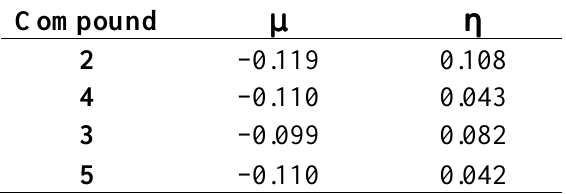
Table 3. Chemical potential ( m ) and Hardness ( h ) in eV for compounds under